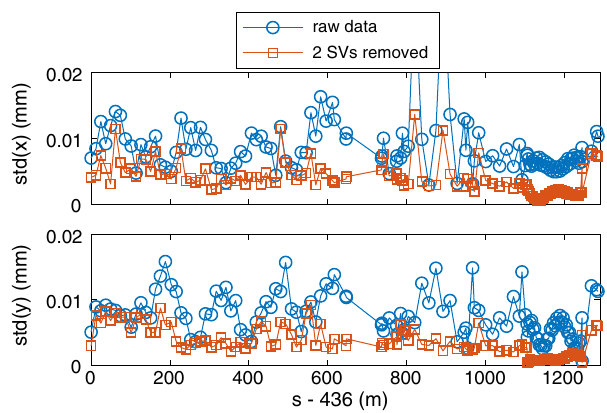
FIG. 7. Standard deviations of trajectory readings at all BPMs with or without the two leading SV modes removed.